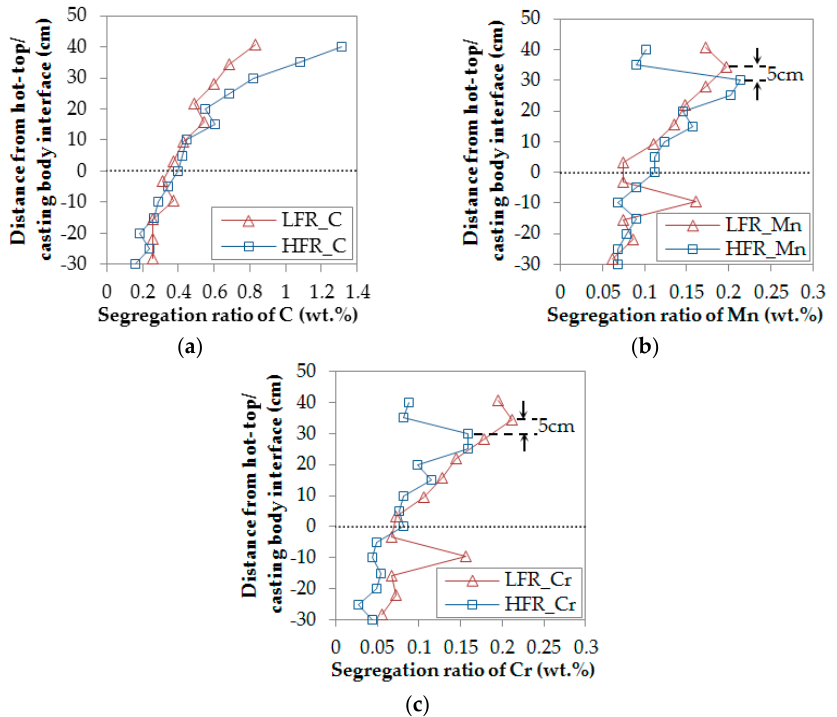
Figure 4. Segregation ratio profiles along the ingot central axis of the two ingots: ( a ) carbon; ( b ) manganese; ( c )